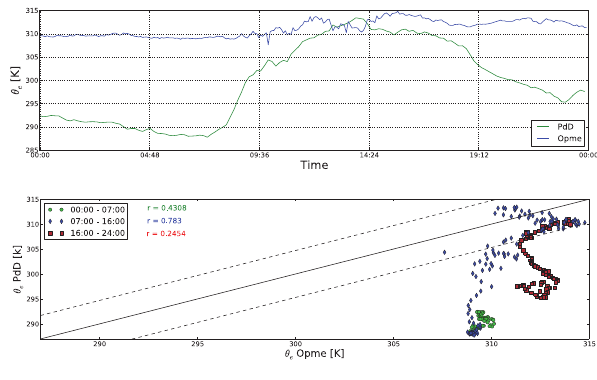
Fig. 9. Temporal evolution of equivalent potential temperature at both sites during a high altitude event (“P”, 13 March 2009).